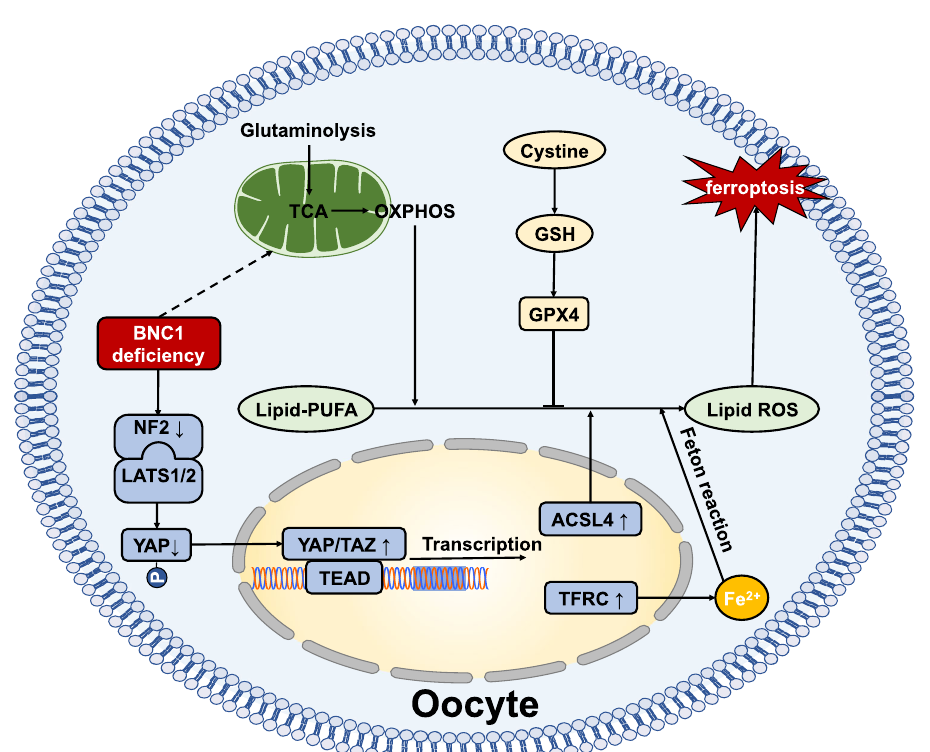
Fig. 8 | Fer-1 partially ameliorates the POI phenotype of the Bnc1 truncation mutation.a Grossof Bnc1 +/+ Con( n =3), Bnc1 tr/tr Con( n =3)and Bnc1 tr/tr Fer-1( n =3) mice at 16 weeks old. b The ovary weights, body weights and ovarian weight coef fi cients of Bnc1 +/+ Con ( n =4), Bnc1 tr/tr Con ( n =6, p value=0.0003 for ovary weight, p value=0.4137 for body weight and p value=0.0009 for ovary weight/ body weight) and Bnc1 tr/tr Fer-1 ( n =4, p value=0.0077 for ovary weight, p value= 0.4395 for body weight and p value=0.0068 for ovary weight/body weight) mice at 16 weeks old. c HE staining of PrFs, PFs, SFs, AFs and AtFs of Bnc1 +/+ Con ( n =3), Bnc1 tr/tr Con ( n =3, p value=0.0073 for PrFs, p value=0.3055 for PFs, p value= 0.3015 for SFs, p value=0.3501 for AFs, p value=0.0382 for AtFs, p value=0.3957 for growing follicles and p value=0.0002 for growing follicles/PrFs) and Bnc1 tr/tr Fer-1 ( n =3, p value=0.4860 for PrFs, p value=0.8158 for PFs, p value=0.2028 for SFs, p value=0.4977forAFs, p value=0.0471forAtFs, p value=0.6138forgrowing follicles and p value=0.4052forgrowing follicles/PrFs)mice at 16weeksold.Scale